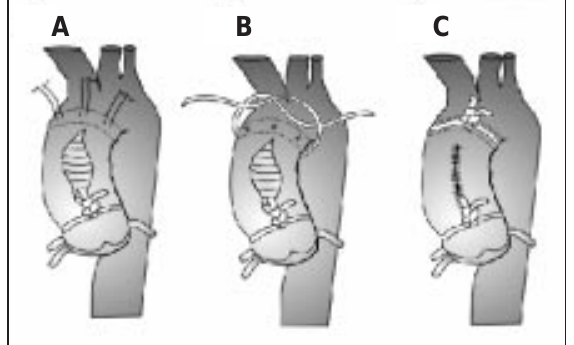
Fig. 3 - Implante intraluminal, sem sutura, de prótese contendo anéis nas duas extremidades.